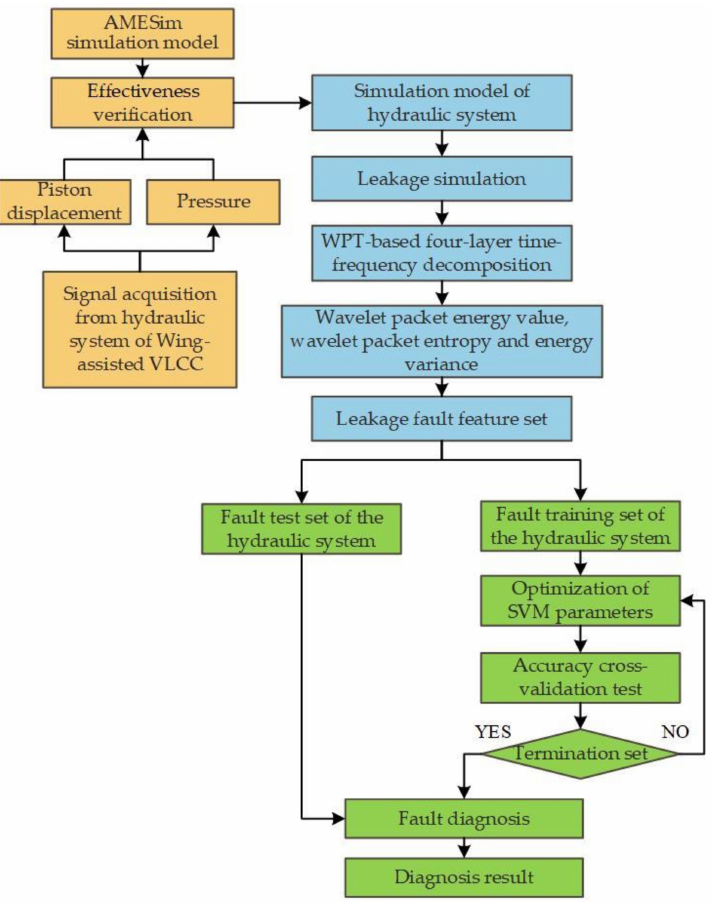
Figure 1. Fault diagnosis process of the wing hydraulic lifting and lowering hydraulic system based on